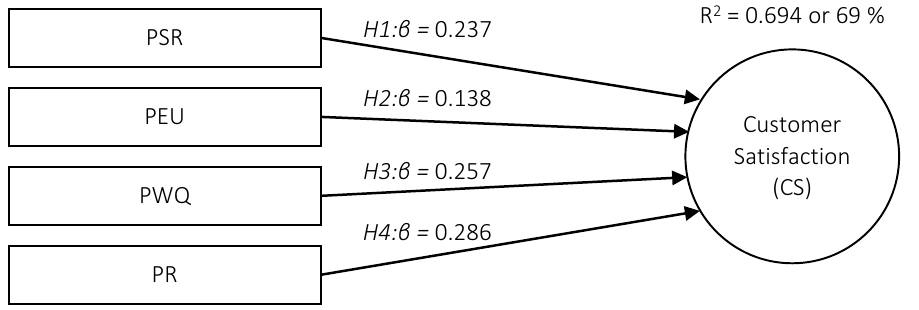
Figure 2. Regression coefficient result